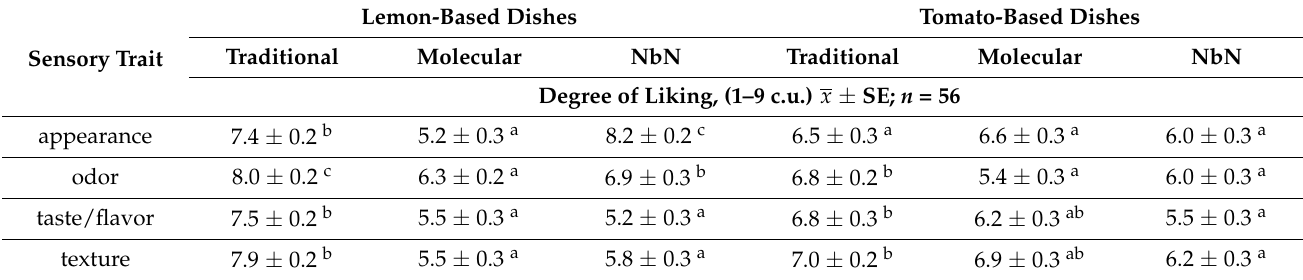
Table 3. Degree of liking of evaluated dishes.